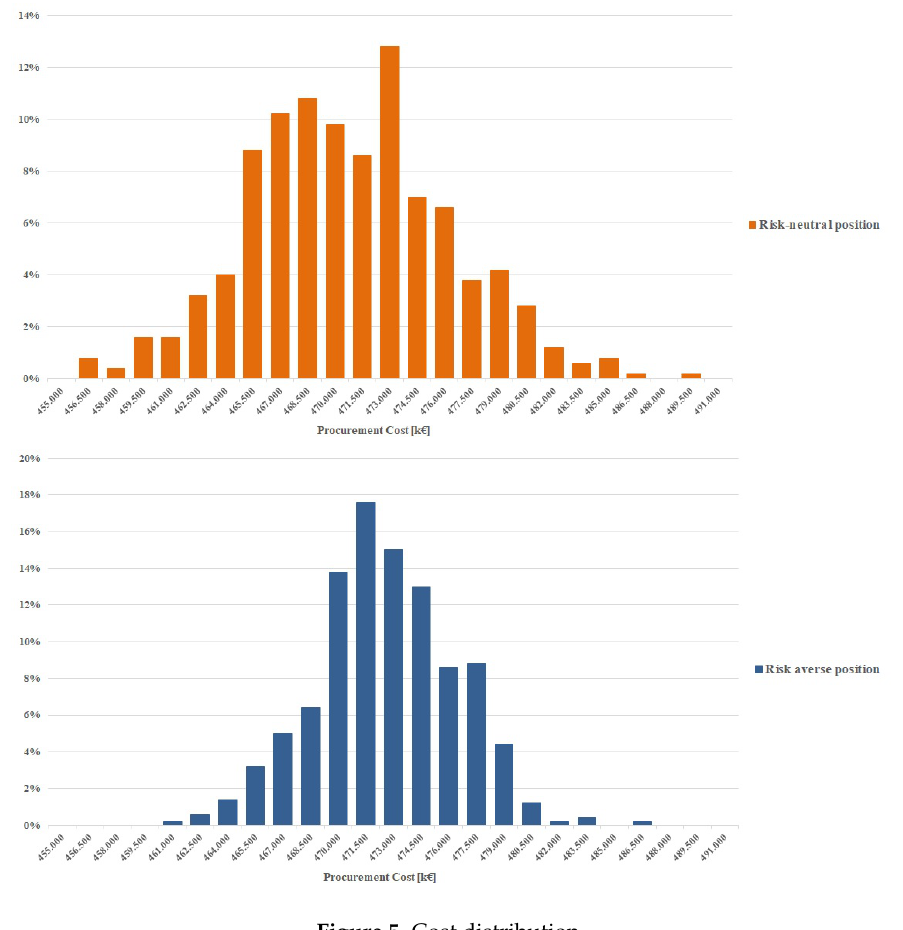
Figure 5. Cost distribution.